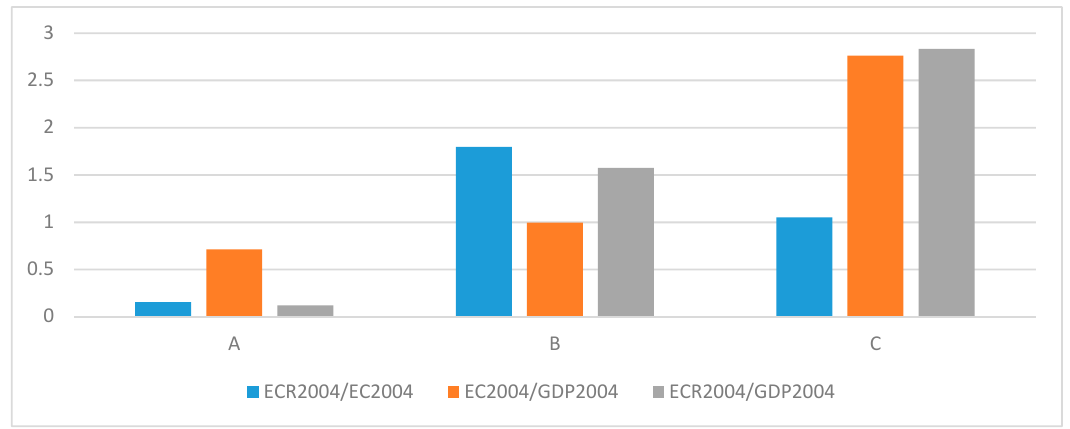
Figure 6. Comparison of group averages for IRE in 2004.